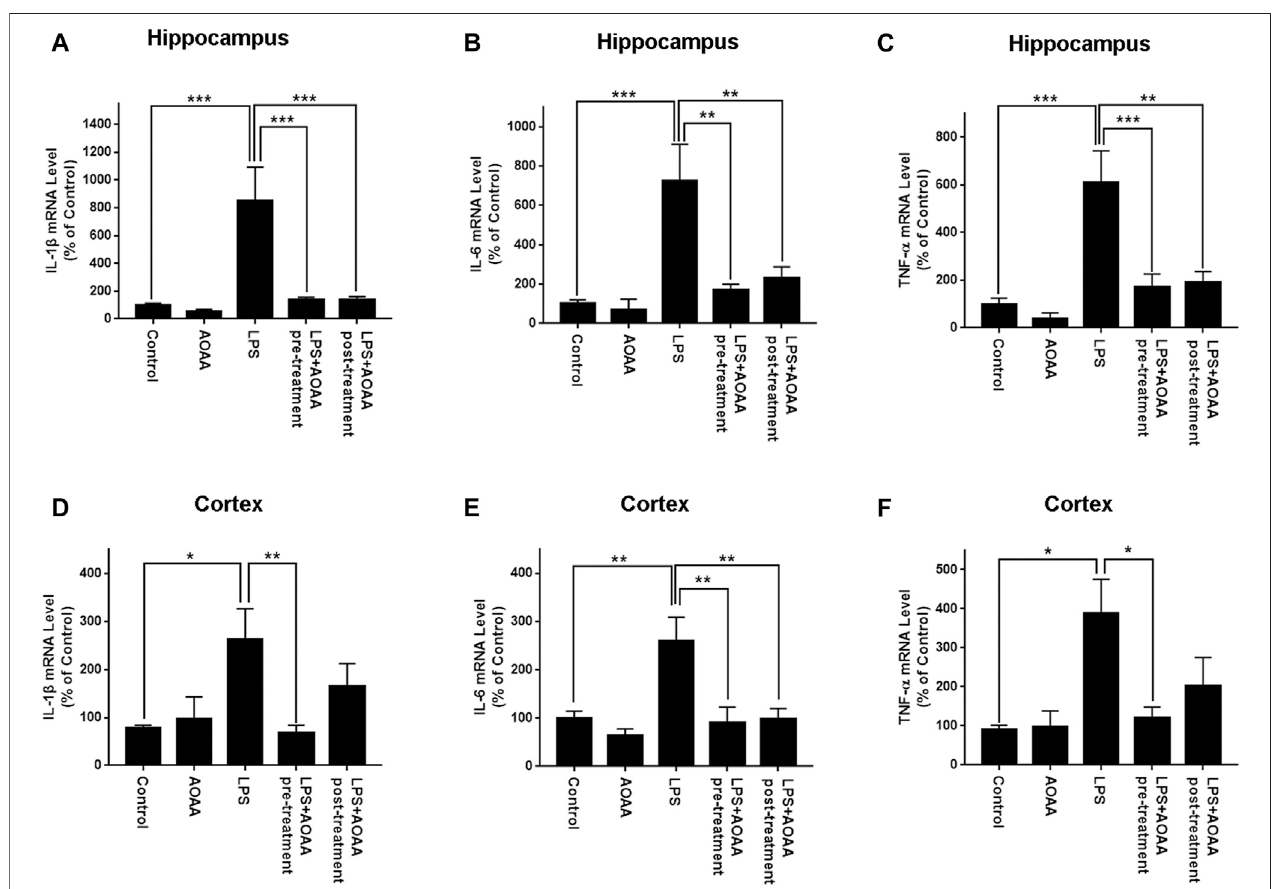
FIGURE3| Real-timePCRassaysshowedthatAOAAsigni fi cantlyattenuatedLPS-inducedincreasesinthelevelsofIL-1 β ,IL-6,TNF- α mRNAinthehippocampus and the cerebral cortex of C57BL/6 mice. (A – C) Real-time PCR assays showed that both AOAA (10 mg/kg, i.p.) pre-treatment and post-treatment signi fi cantly attenuated LPS-induced increases in the levels of IL-1 β , IL-6, TNF- α mRNA in the hippocampus of the mice. (D – F) Real-time PCR assays showed that both AOAA (10 mg/kg, i.p.) pre-treatment and post-treatment signi fi cantly attenuated LPS-induced increasesin the levels ofIL-1 β , IL-6, TNF- α mRNA in the cerebral cortex of the mice. The mice were administered with LPS (250 μ g/kg, i.p,). AOAA was administered 3 days before LPS administration or 3 days after LPS administration. 7 days after the LPS administration, Real-time PCR assays were conducted. N (cid:2) 5. *, p < 0.05, **, p < 0.01.